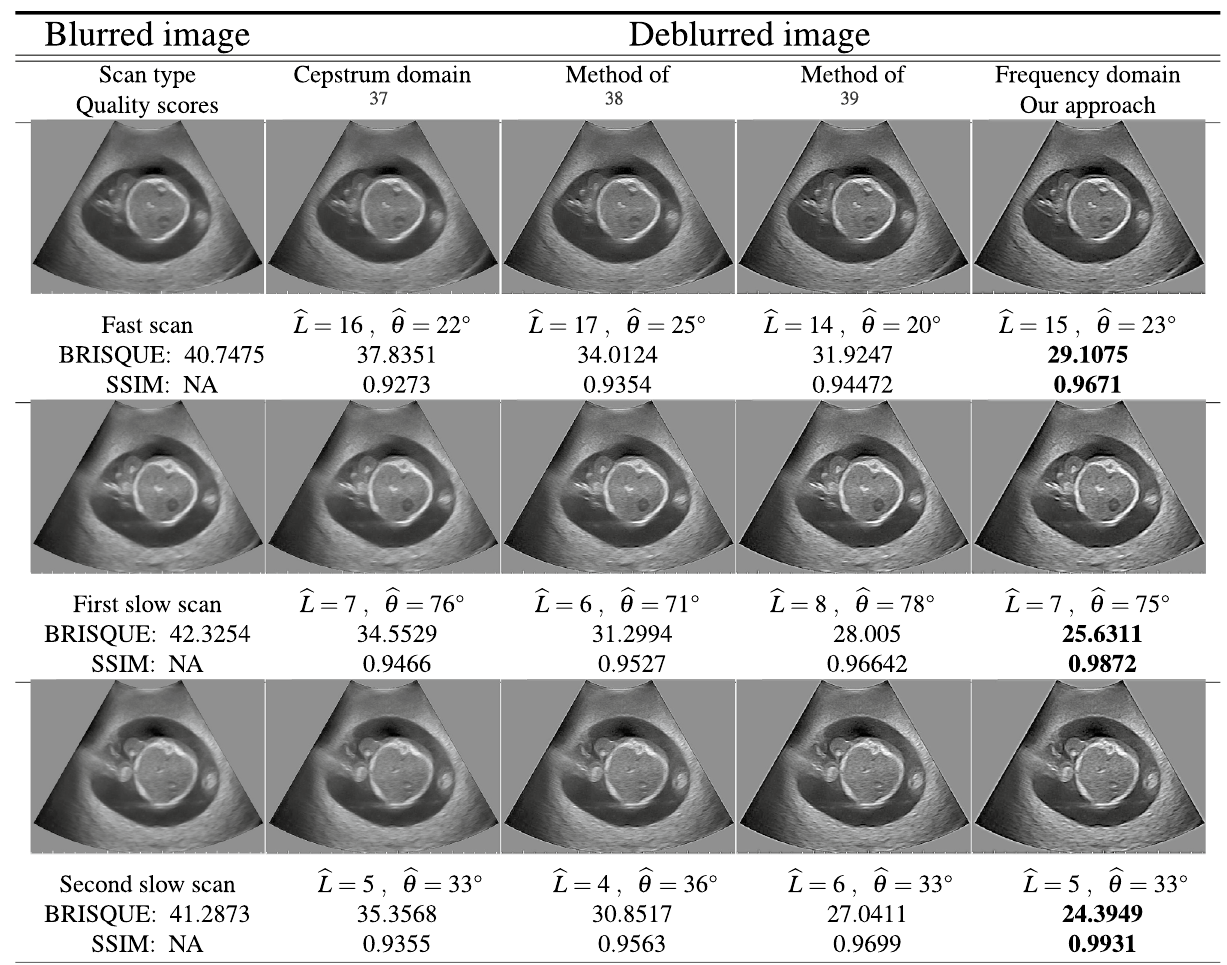
Table 4. Fetal phantom image deblurring using three different methods compared with frequency domain (proposed scheme using estimated motion algorithm) and their corresponding BRISQUE/SSIM